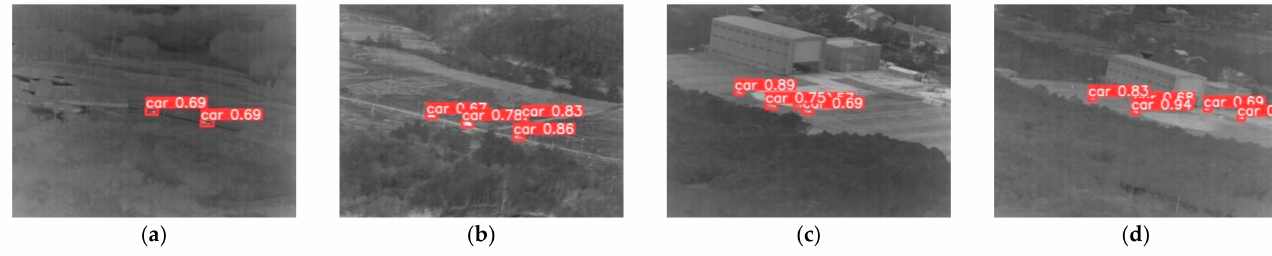
Figure 23. Dense + SE detection diagram. ( a ) Scene 1. ( b ) Scene 2. ( c ) Scene 3. ( d ) Scene 4.